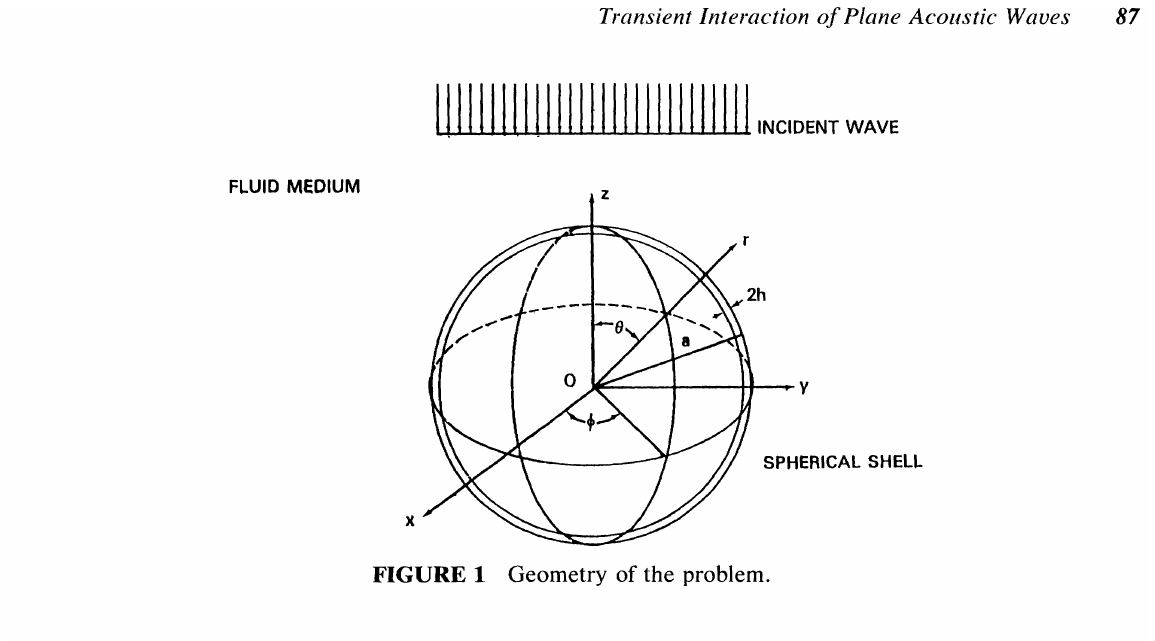
FIGURE 1 Geometry of the